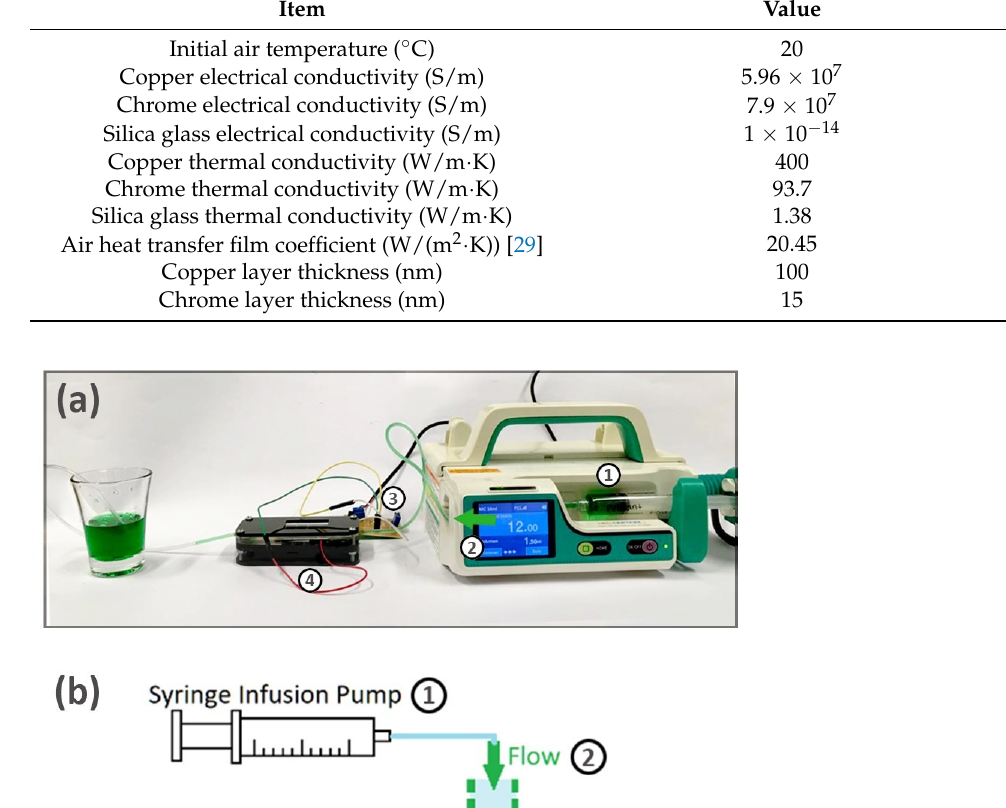
Table 1. Properties used in the electrothermal simulation in COMSOL Multiphysics TM , with proper- ties given by the material selected in the simulation.